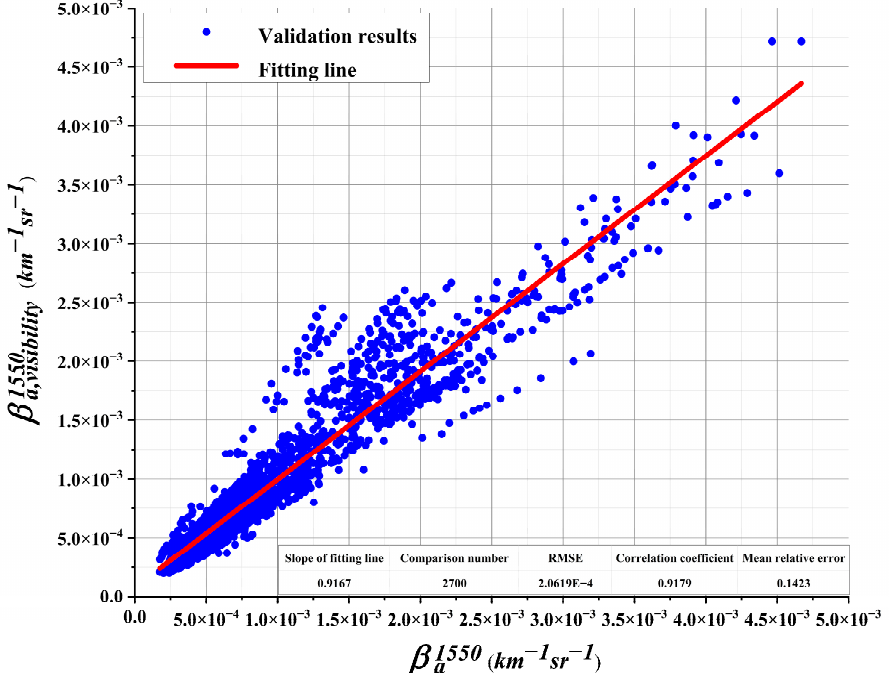
Figure 9. Validation results of all joint measurements for retrieval method with atmospheric visibility. The blue dots are the relationship of β 1550 a and β 1550 , the red line is obtained by linear fitting of validation results, the embedded table shows the detailed evaluation indicators of this retrieval method.